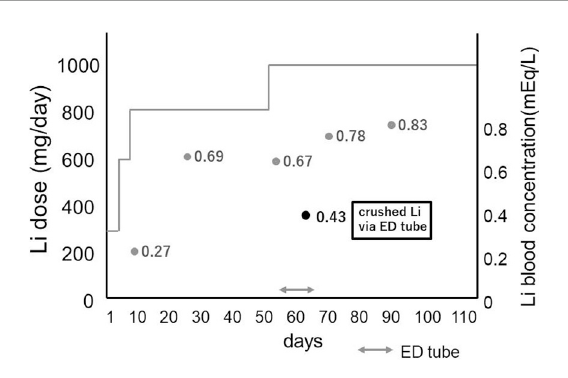
FIGURE1 Diagram of Li dosage and progress: when Li was administered via elemental diet tube, Li blood concentration decreased compared to oral administration by the same dose. Li: lithium carbonate, ED tube: elemental diet tube.